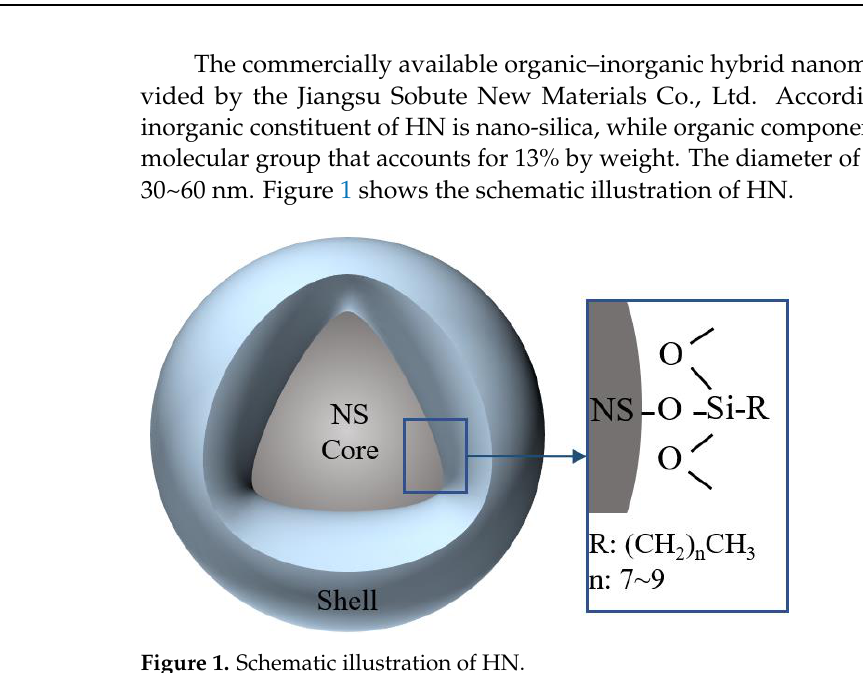
Figure 1. Schematic illustration of HN.